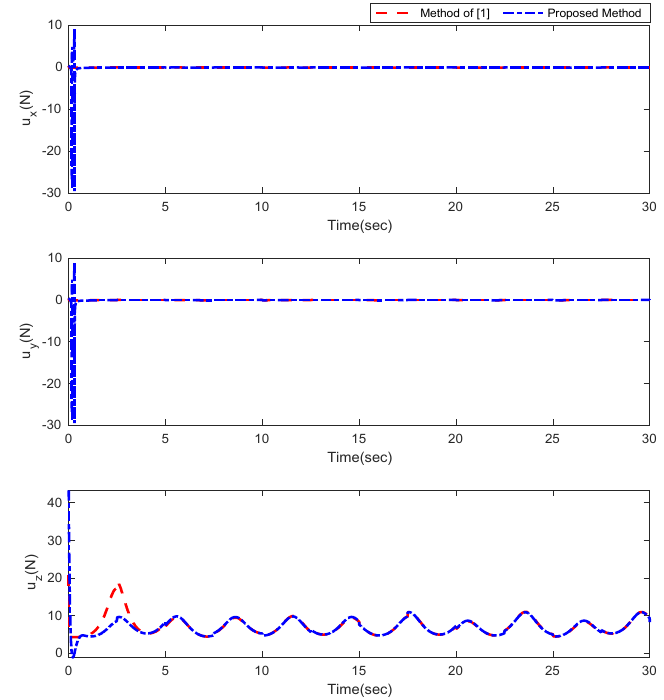
Figure 8. Control inputs relevant to position of quadrotor.